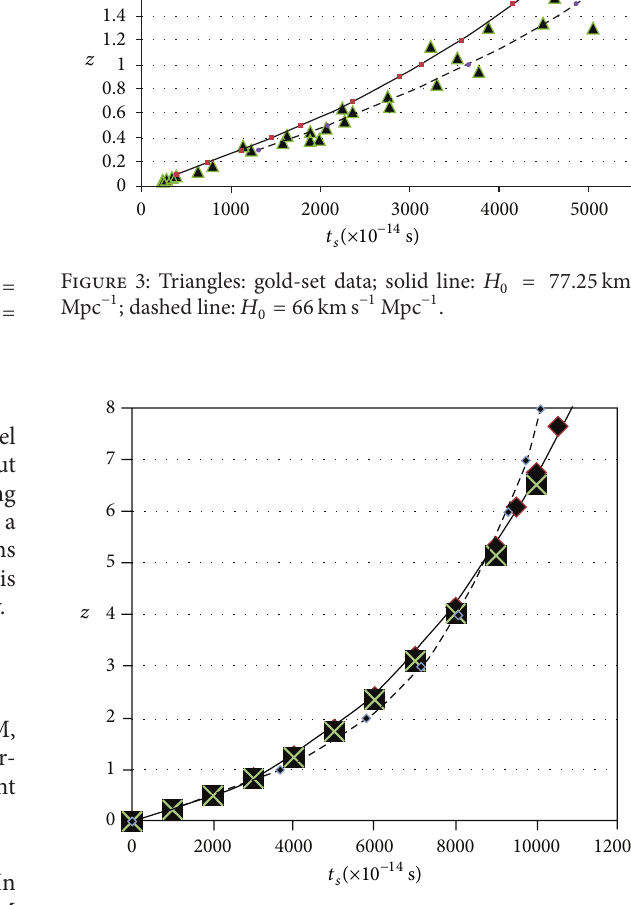
Figure 4: Redshift of Type Ia supernovae as a function of 𝑡 𝑆 = /𝑐 . Solid line: RS/ 𝑡 𝐷 𝐶 𝑆 relation inferred from the potential best- fit curve of the RS/ 𝜇 diagram. Diamonds: the potential rela- tion with 𝐻 0 = 2.05 × 10 −18 Hzs −1 Hz −1 . Crosses: RS for the SEU with 𝐻 0 = 2.017 Hzs −1 Hz −1 + RS resulting from expansion with 5 kms −1 Mpc −1 . Dashed line: RS/ 𝑡 𝑆 relation derived from the distances 𝐷 𝐶 obtained from the Λ CDM model with 𝐻 0 = 66 kms −1 Mpc −1